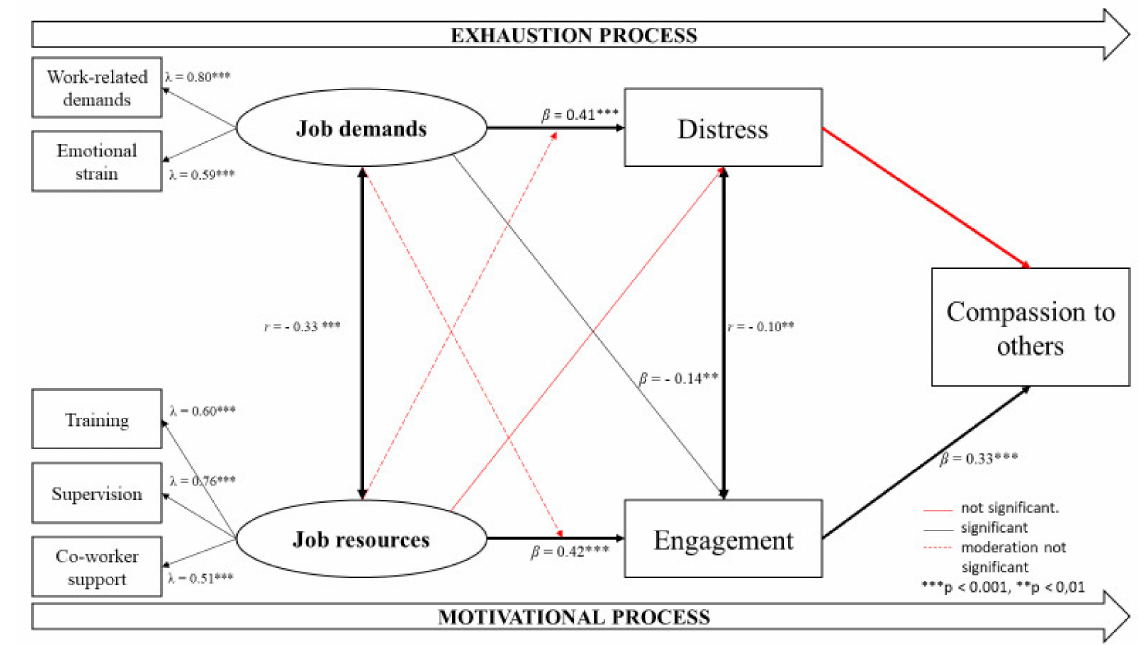
Figure 1. The job demands-resources model in crisis line